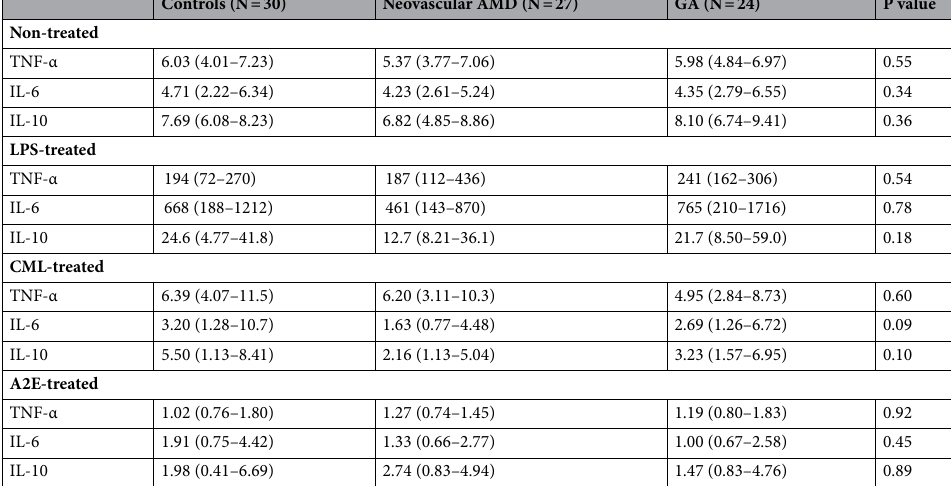
Table 2. Cytokine expression of TNF-α, IL-6, IL-10 for different stimulation conditions in patients with neovascular AMD or geographic atrophy (GA) and a control series. Numbers are presented as fold- change where relative expression was calculated from the differences in cycle threshold (Ct) of the internal standard (GAPDH) compared to the target mRNA with and without treatment (ΔΔCt). Data are presented as median values with interquartile ranges. P values denote were calculated using an independent samples median test. AMD age-related macular degeneration, GA geographic atrophy, LPS lipopolysaccharide, CML Nε-carboxymethyllysine, A2E N -retinyl- N -retinylidene ethanolamine, TNF -α tumour necrosis factor α, IL